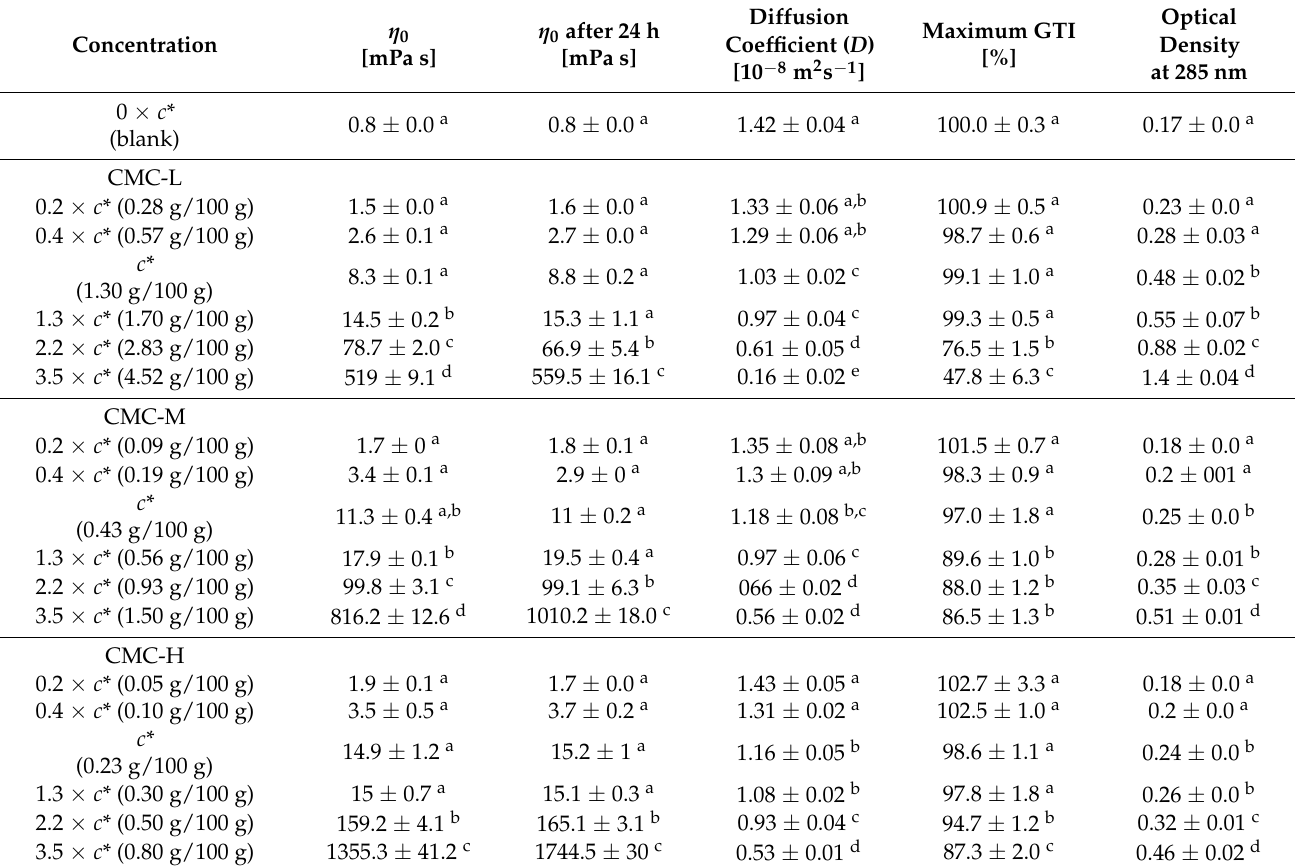
Table 2. Zero-shear viscosity before and after 24 h release experiment, diffusion coefficient and optical density at different concentrations around the c * of CMC-L, CMC-M,